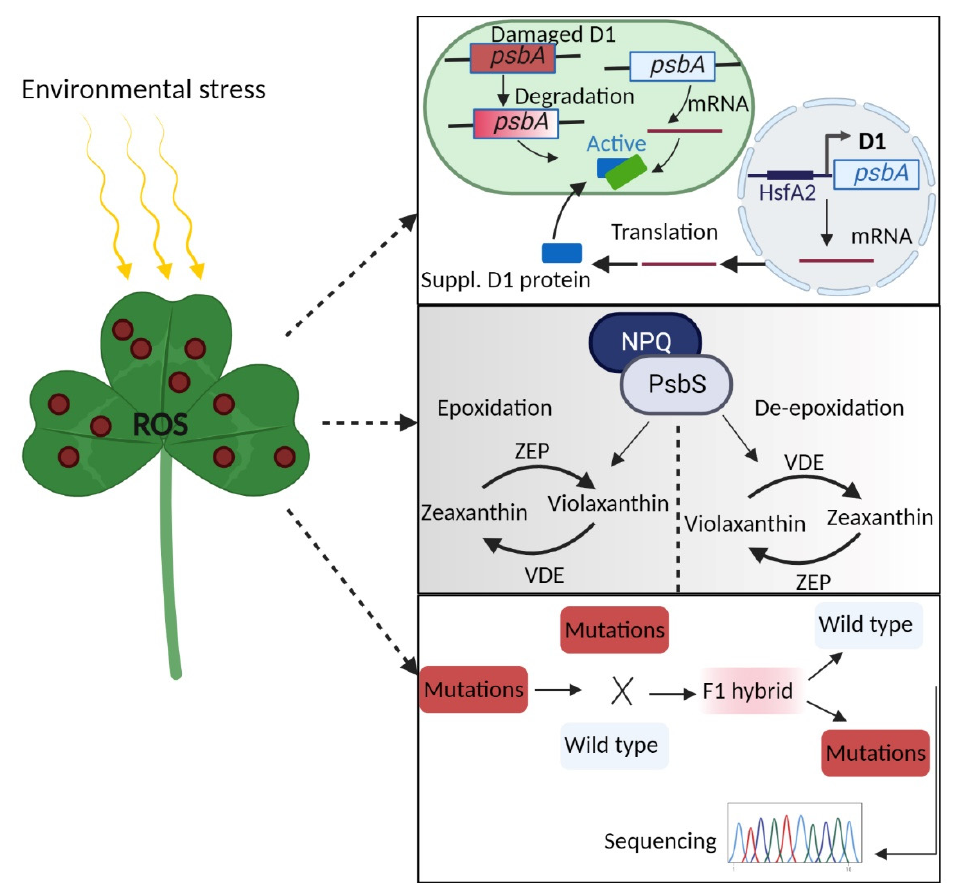
Figure 5. Manipulation of ROS toxicity in response to environmental cues. Excessive ROS production under extreme environment damage chloroplast-related proteins. Using bioengineering approaches, supplementing the nuclear D1 protein pathway into chloroplast and installation of xanthophyll cycle mediating reversible inter-conversion of ZEP and VDE could enhance photosynthetic efficiency. In addition, functional characterization of random mutations could help plants to adapt to undesirable environmental cues efficiently.